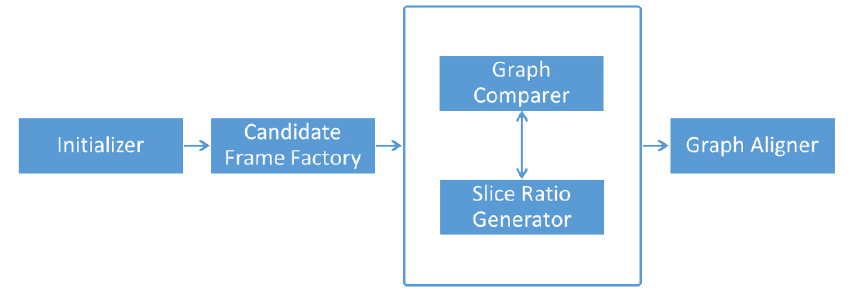
Figure 1. The operation sequence of the modules composing the TSPDA.